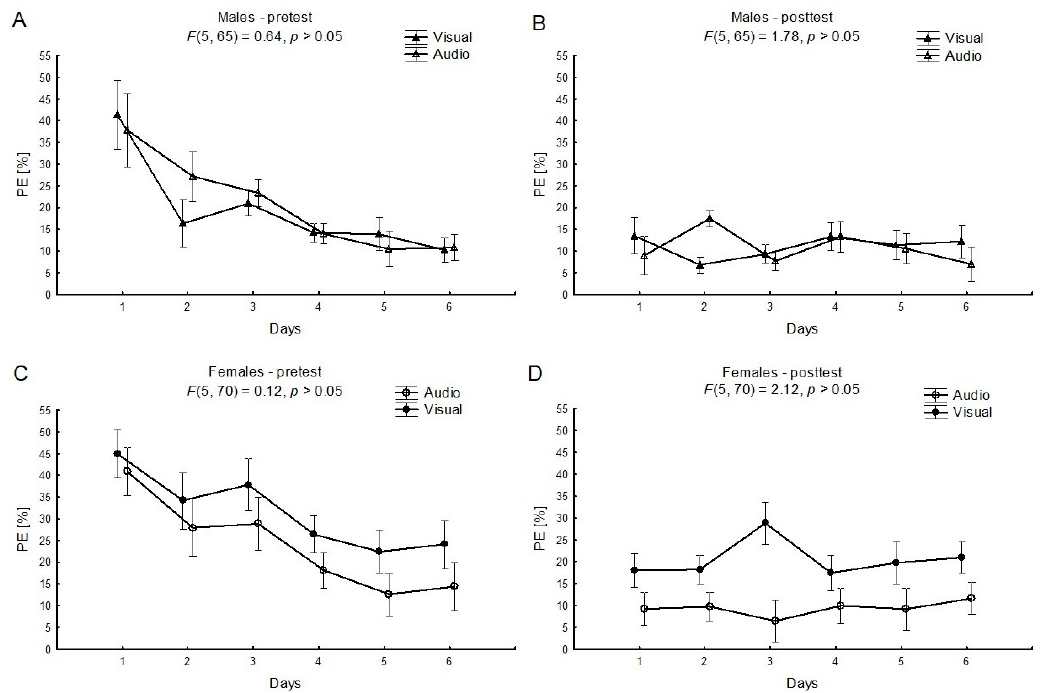
Figure 4. The mean relative values and standard errors of the performance error PE [%] for the “feedback × time” factor (the audio vs. the visual feedback), separately for the pretest and the posttest, for males ( A , B ) or females ( C , D ).